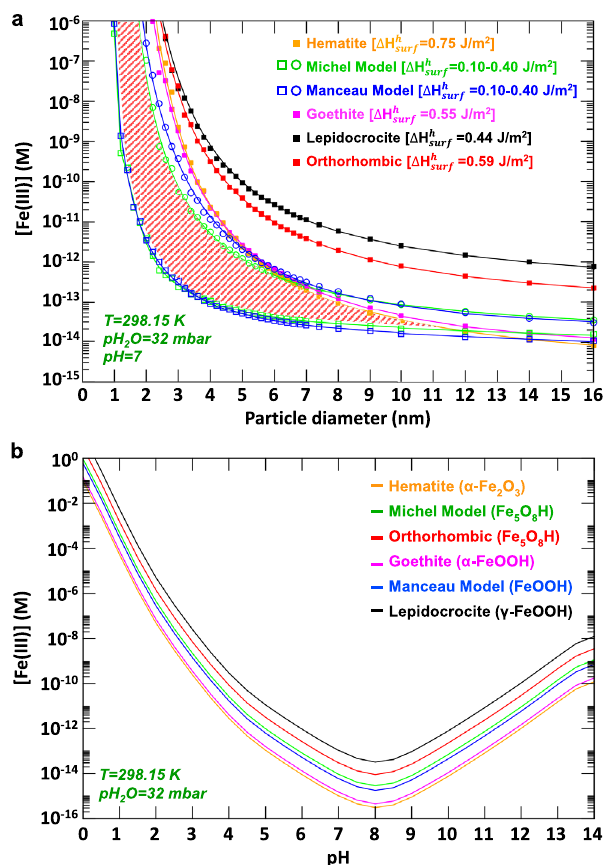
Fig. 6 Solubility of iron-oxyhydroxide phases. Equilibrium solubility of [Fe(III)] for the various minerals in pure water. a Particle-size dependence of [Fe(III)] solubility at pH = 7. The red hatched area represents the size range of particles for which the two ferrihydrite models can potentially coexist. b pH-dependence of [Fe(III)] solubility of iron (oxyhydr)oxide phases considered as virtual bulk